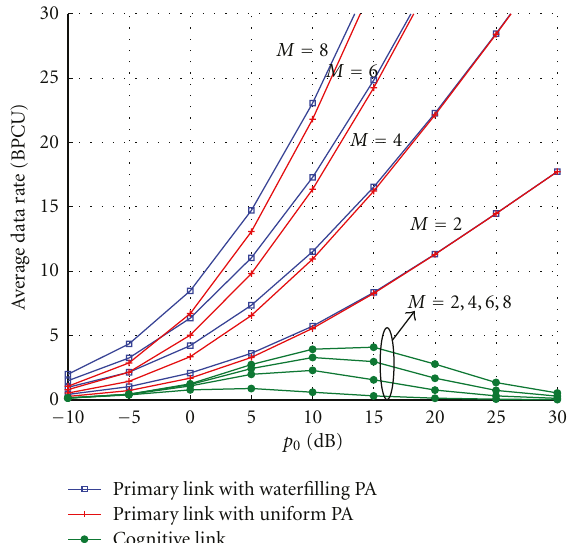
Figure 4: Average data rate for both the primary and the secondary networks versus the power allocation level δ (linear scale); M = 4, and p 0 = 10dB.